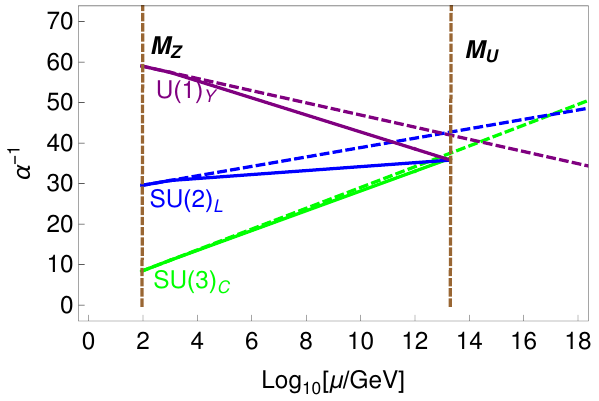
Figure 1 . Evolution of the gauge coupling constants of SM gauge symmetry, where dashed lines are contributions from SM particle content and solid lines correspond to RGEs with SM plus R and Σ . The vertical dotted lines from left-right are representing symmetry breaking scales M electroweak scale and M as unification U